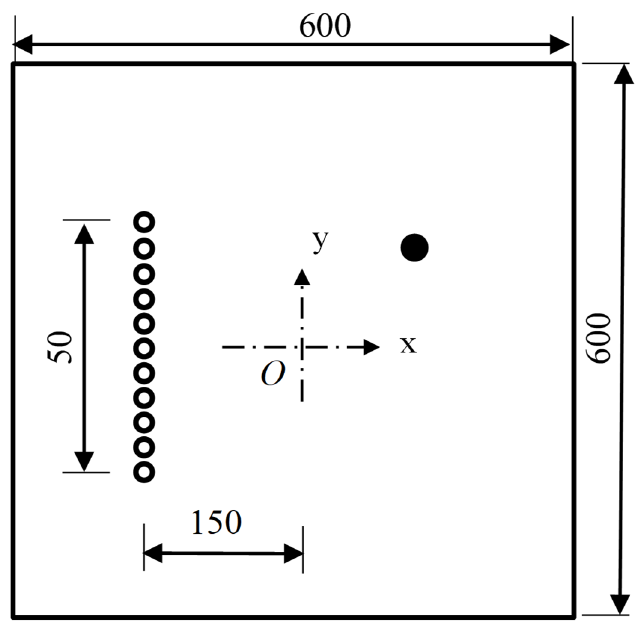
Figure 2. Schematic diagram of finite element model.